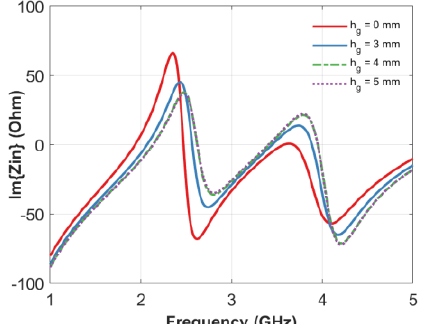
Figure 8. Effect of the presence of an air gap around the connector tip and the dielectric material (see Figure 6) on the imaginary part of impedance Im(z). All curves refer to a tag with total height h d = 22 mm, height of void inclusions h r = 14.5 mm and void inclusions radii R 1 , R 2 , R 3 , R 4 = 10, 13, 25, 28 mm, respectively.